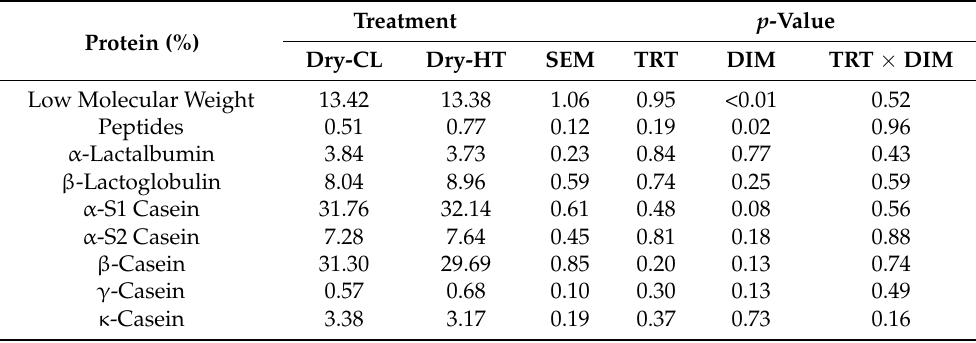
Table 1. Effect of dry period heat stress on milk protein profile during lactation. Cows were exposed to dry period heat stress (dry-HT, n = 6) or cooling (dry-CL, n = 6) for 46 days pre-calving. Milk was collected at 14, 42, and 84 days in milk (DIM) and analyzed for milk protein fractions. Data are presented as least square means ± standard error of the treatment (TRT). Protein (%)